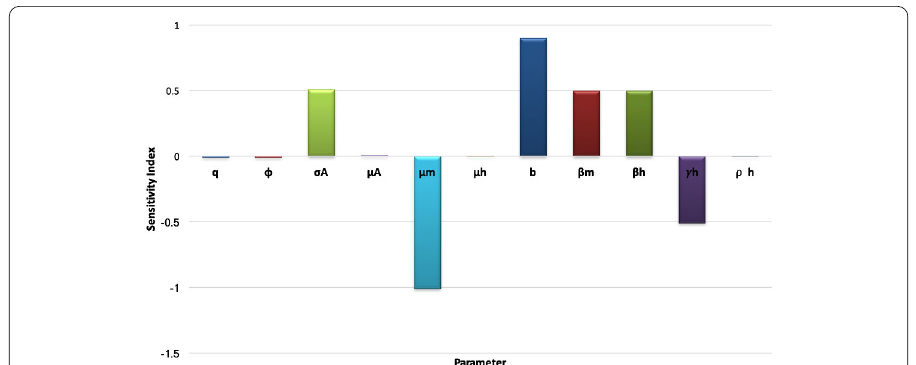
Figure 1 Sensitivity indices of R 0 with respect to the parameters in (4) for α = 0.9